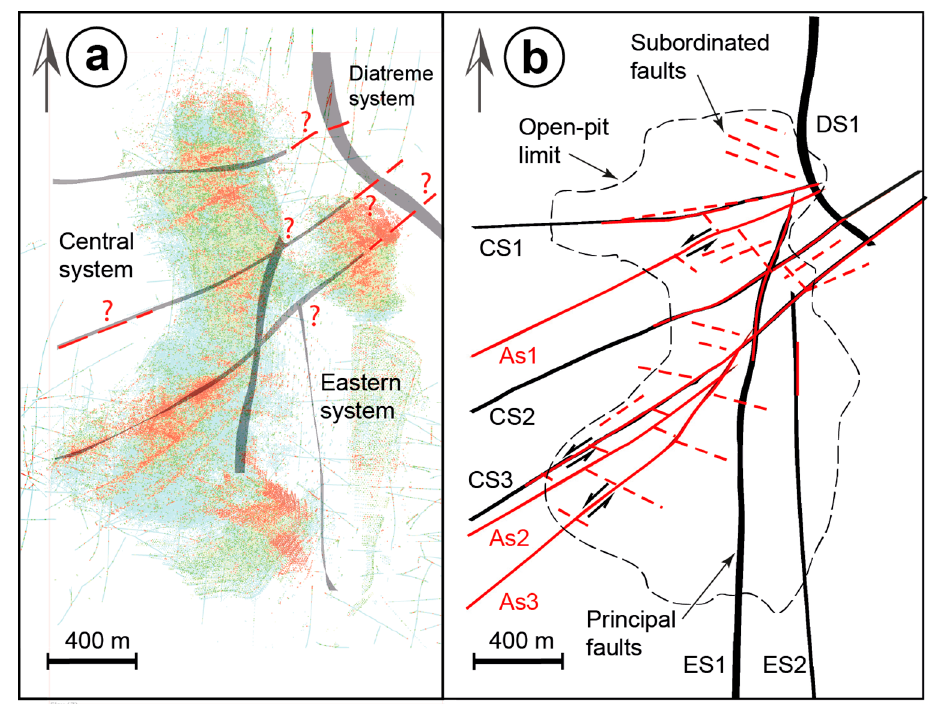
Figure 8. The Arsenic -improved structural model. ( a ) Spatial correlation between the As -database orthographic projection and the currently-used structural model. ( b ) Main progress in the structural model, including the three newly-revealed principal faults as well as the real persistence and cross-cutting fault relationships.